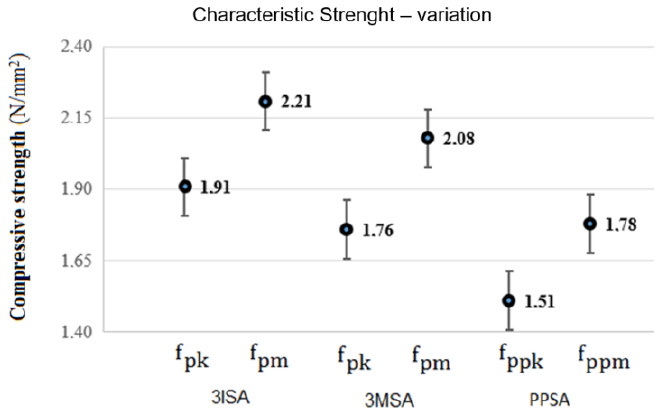
Figure 9. Compressive strength in N/mm 2 (characteristic and average).